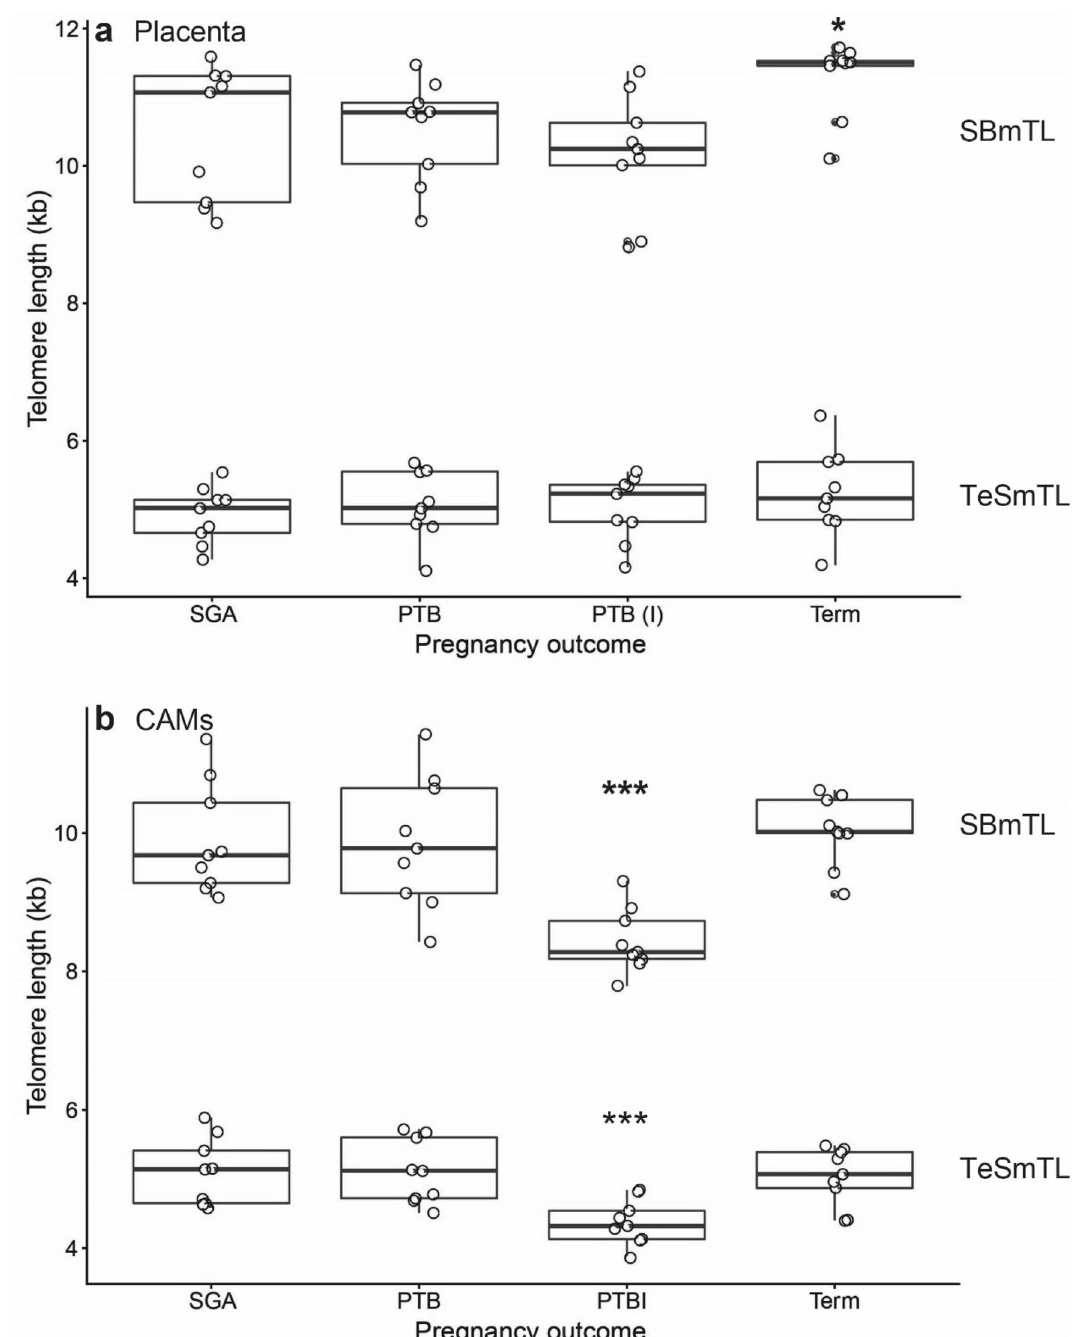
(Groups): small for gestational age (SGA), pre-term birth (PTB), pre-term birth with intra-amniotic infection (PTBI). * P < 0.05; *** P < 0.001. n = 9 for each